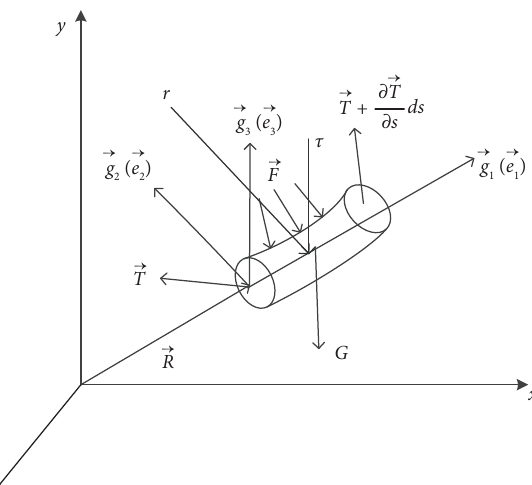
Figure 1: Schematic diagram of force analysis about cable structure